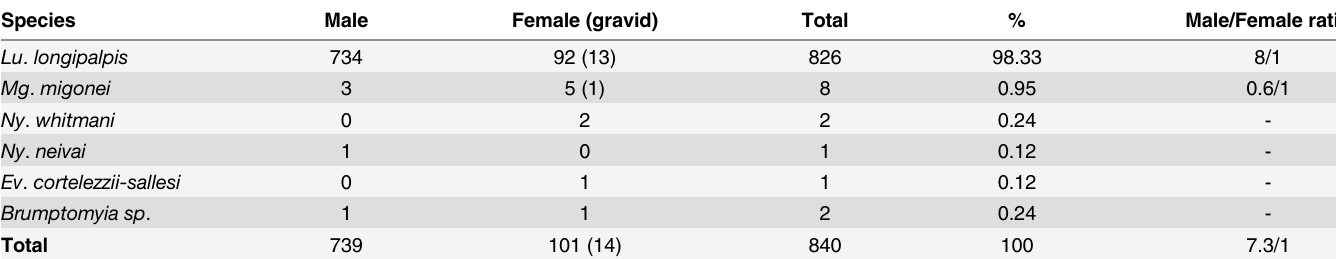
Table 3. Phlebotominae fauna by species and